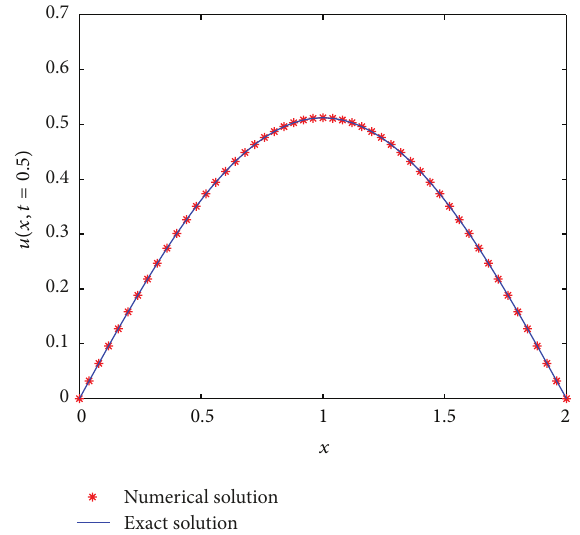
Figure 7: Comparison of the analytical solution and numerical solution for 𝛼 = 1.6 by Numerical Algorithm II (see (61)) with ℎ = 0.04, 𝜏 = 0.005 , which satisfy the stability (83).